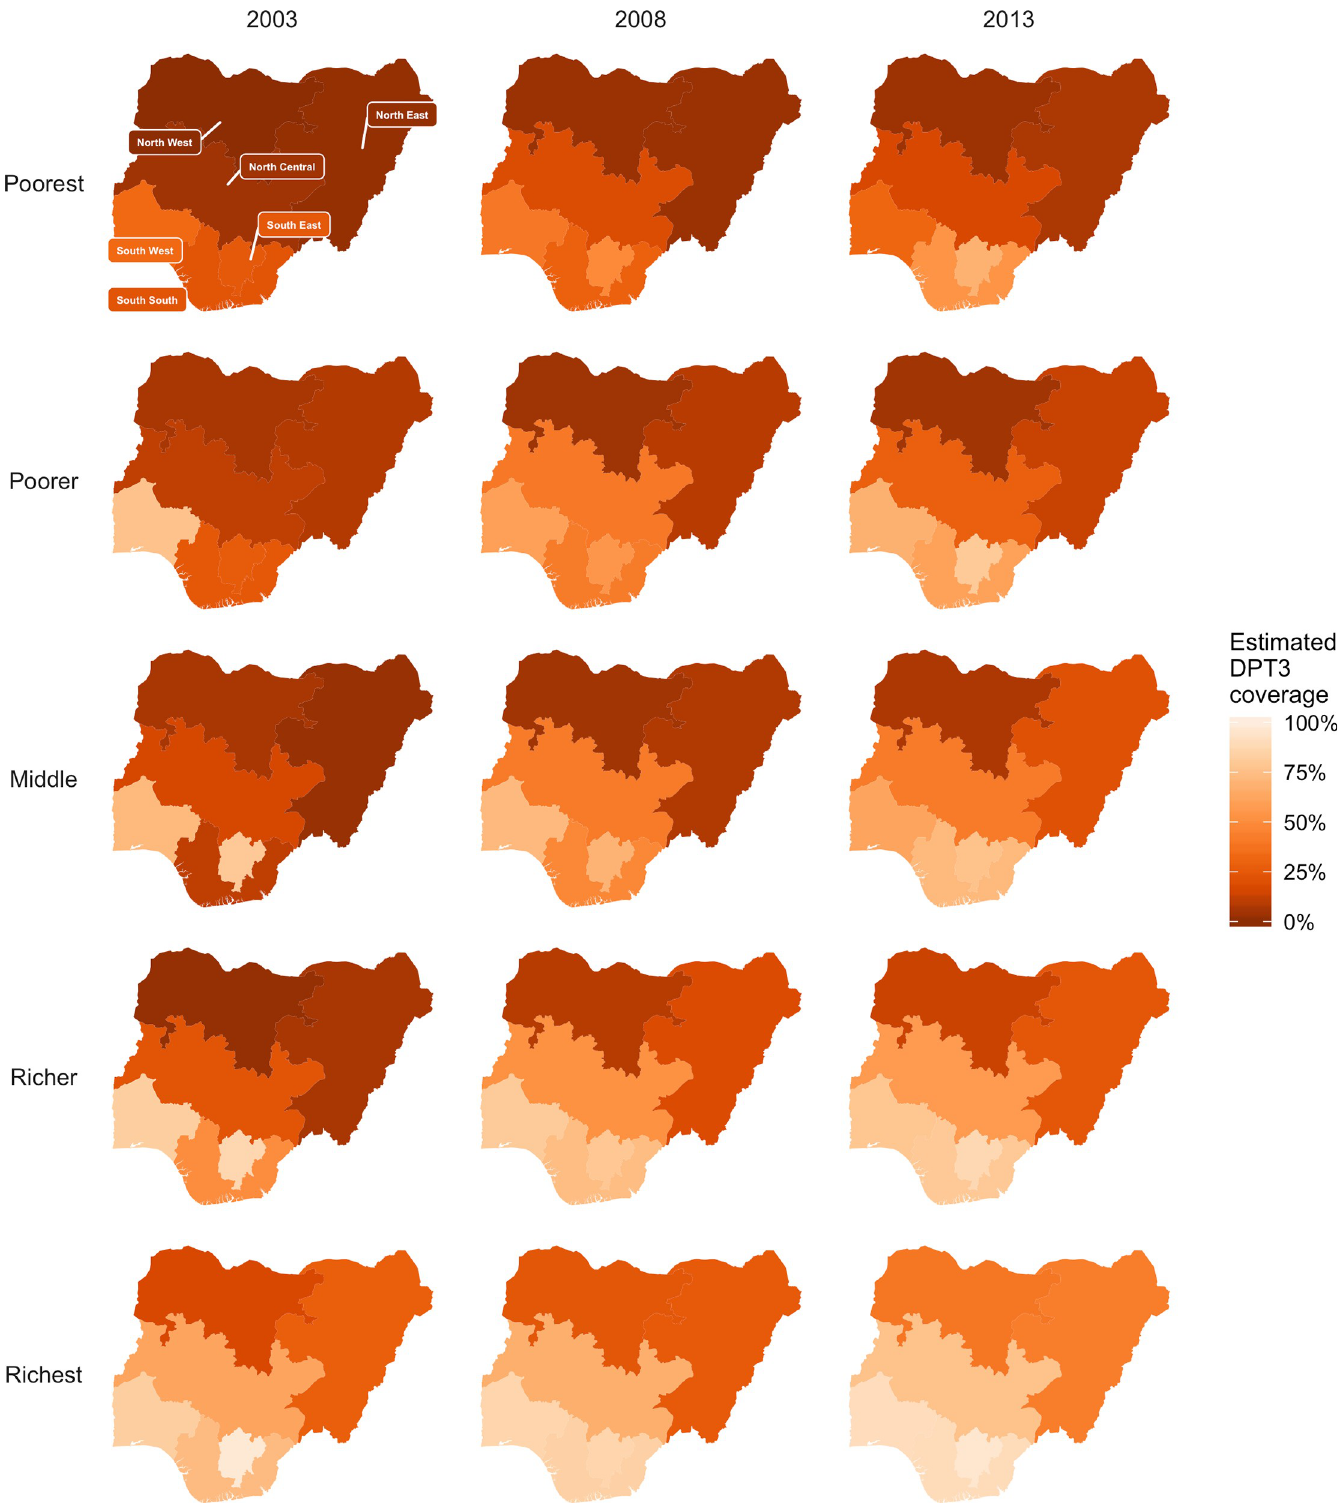
Fig 3. Estimated DPT 3 vaccination coverage, used as a proxy for estimating a 3-dose rotavirus vaccination schedule for each regional wealth quintile across the most recent three NDHS: 2003, 2008, and 2013. Darker orange indicates lower vaccination coverage while lighter orange is closer to full coverage.